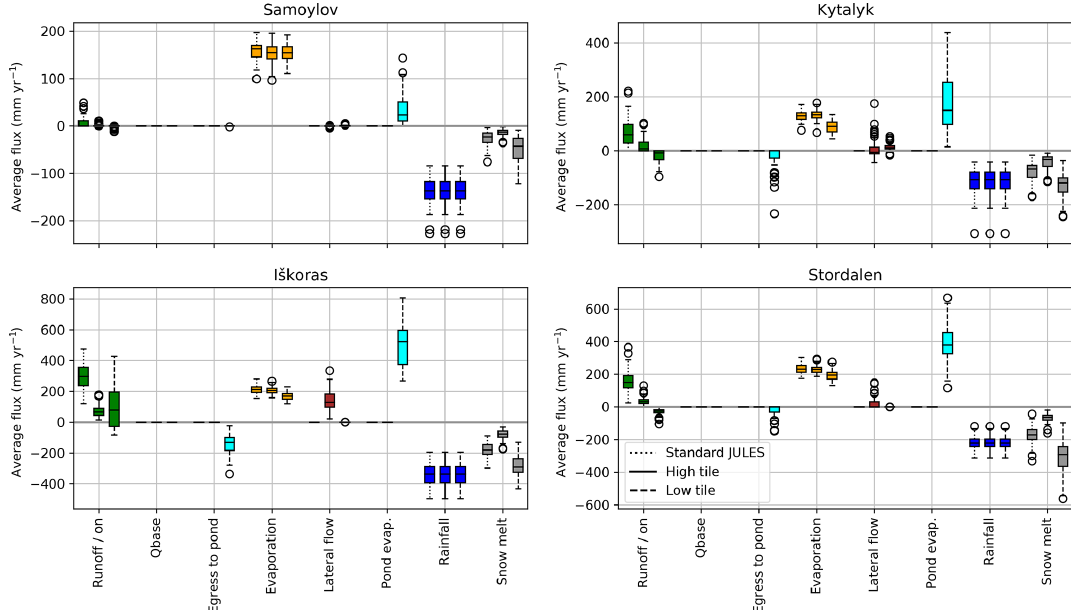
Figure 8. Boxplot of average yearly simulated moisture fluxes (1950–2016) for standard JULES and the two tiles for each site. Negative fluxes are incoming fluxes. Following the discussion in Sect. 3.2.1, this plot shows the configuration with qbase switched off.